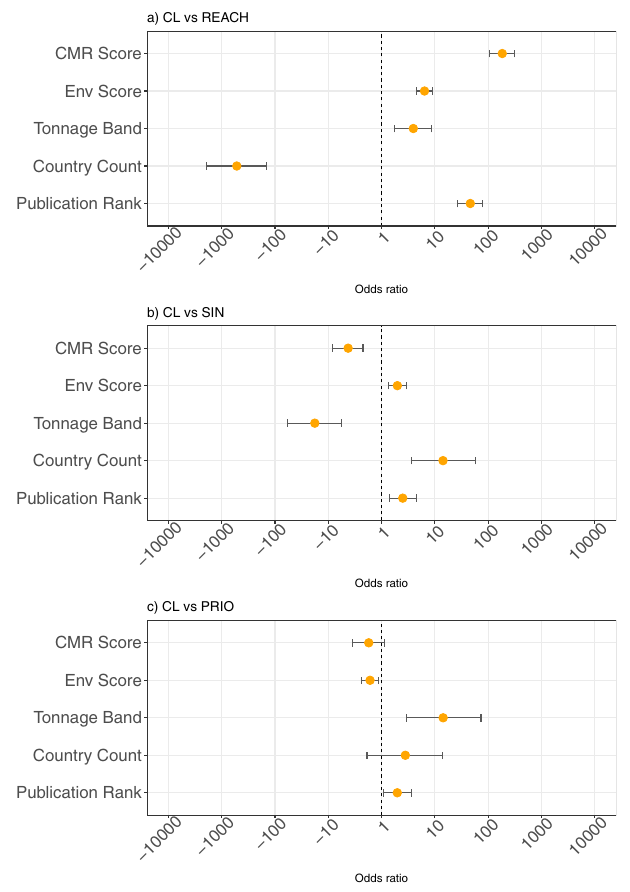
Fig.2| Marginalcontributionofexplanatoryvariablestotheoddsofinclusion on Candidate List. The fi gure presents the point estimates of the odds ratio and the corresponding 95% con fi dence interval for all parameters included in the logit model where the likelihood of inclusion on the Candidate List is predicted by the toxicological properties of the substances as well as the economic and knowledge parameters.ChemicalslistedintheCandidateListarecomparedto( a )allchemicals registered under the European chemical regulation Registration, Evaluation, Authorization, and Restriction of Chemicals (REACH, n =15,169), ( b ) chemicals listed on the SIN list (SIN, n =874), and ( c ) chemicals listed on the PRIO list (PRIO, n =856).Parameterswithestimatestotheleftoftheverticallineat1willtypicallybe of lower value in the Candidate List as compared to the list with which it is com- pared, and vice